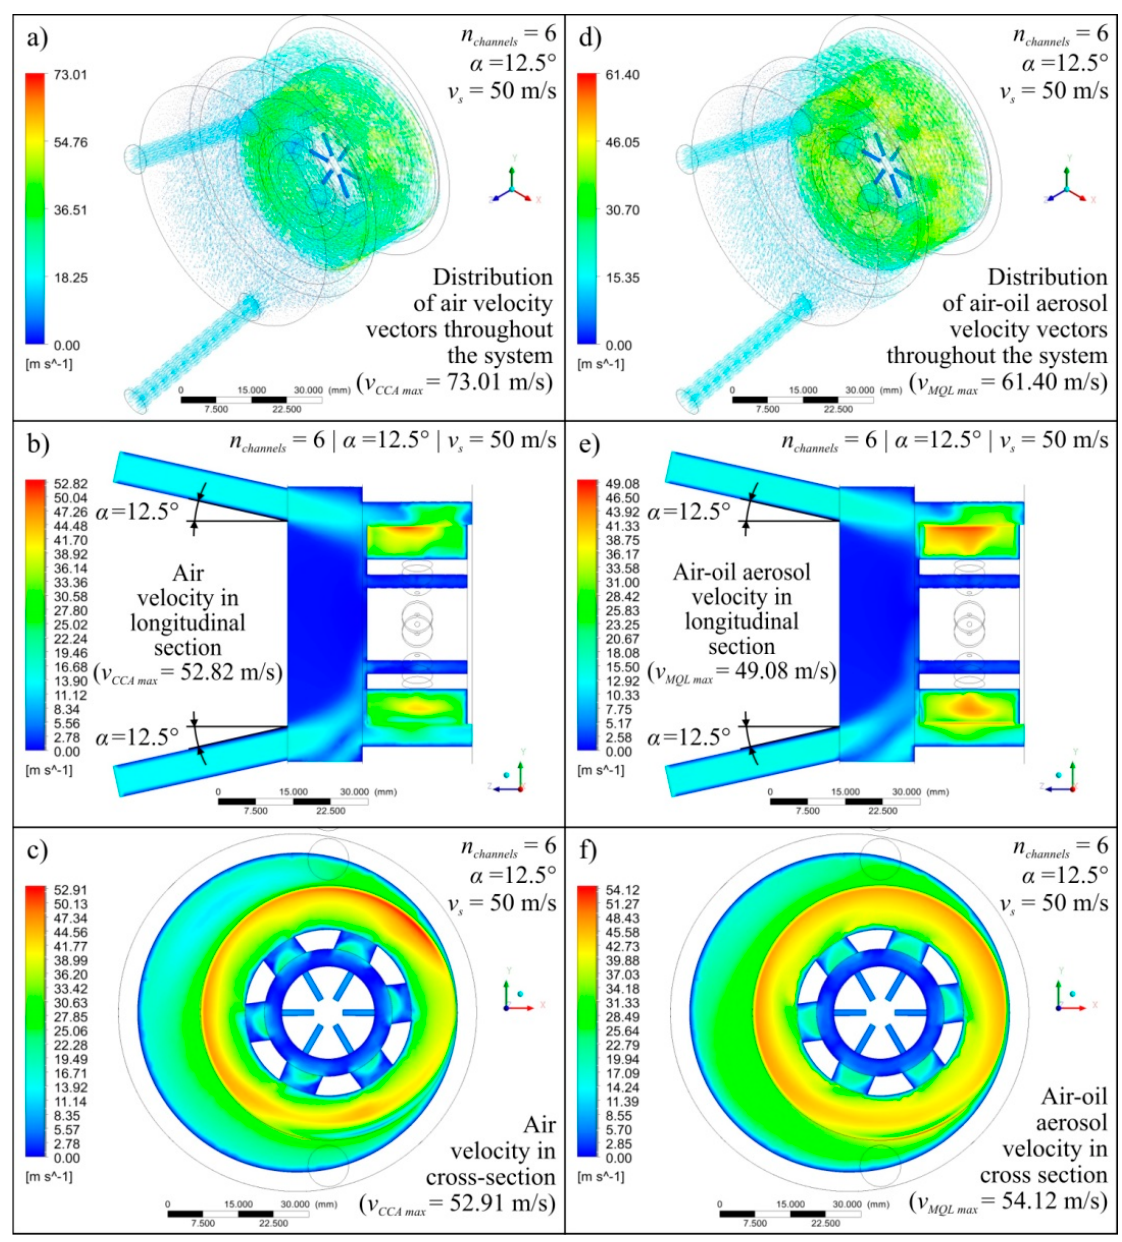
Figure 8. Exemplary simulation results for α = 12.5°, n channels = 6 and v s = 50 m/s presented as colour maps of air flow velocity ( a – c ) as well as oil mist flow velocity ( d – f ) in the entire system ( a , d ), in longitudinal section ( b , e ) and in cross-section ( c , f ).